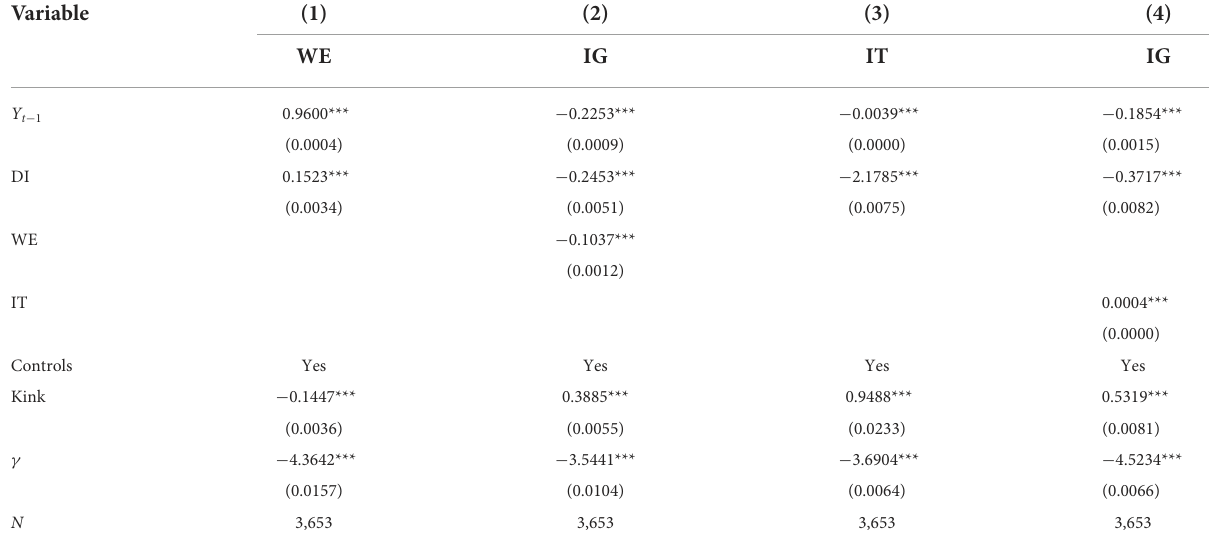
TABLE 5 Transmission mechanism